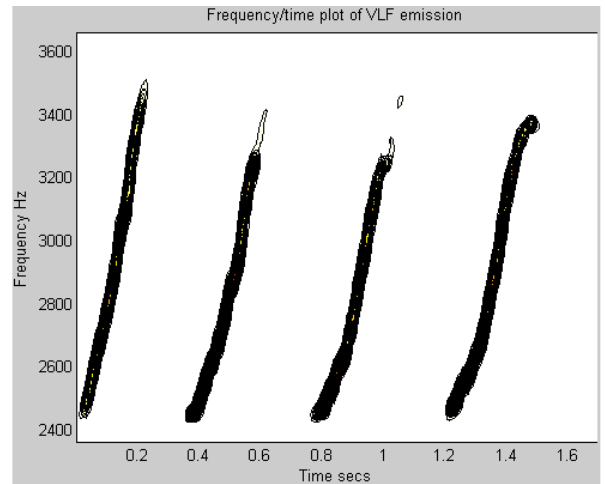
Fig. 9. Spectrogram of rising frequency chorus element for the case Fig. 9. of a cold plasma density Ne=5 electrons/cc. The consistency, repro- ducibility and stability of the different elements are noteworthy, as is their constant time